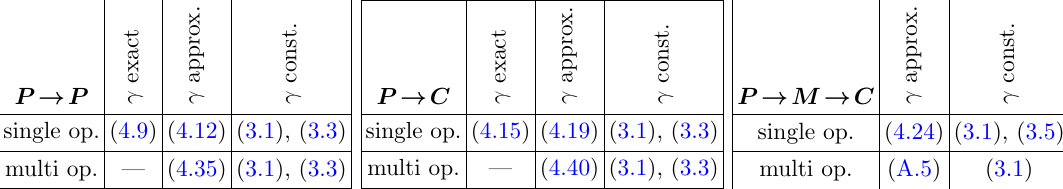
Table 1 . Summary of equations relevant for parent-parent mixing ( P ! P ), one-loop parent-child mixing ( P ! C ) and two-loop parent-mediator-child mixing ( P ! M ! C ) with di(cid:11)erent levels of